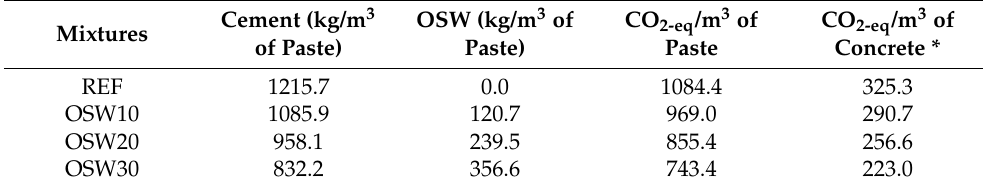
Table 4. Composition and CO 2 -eq emission of 1 m 3 of